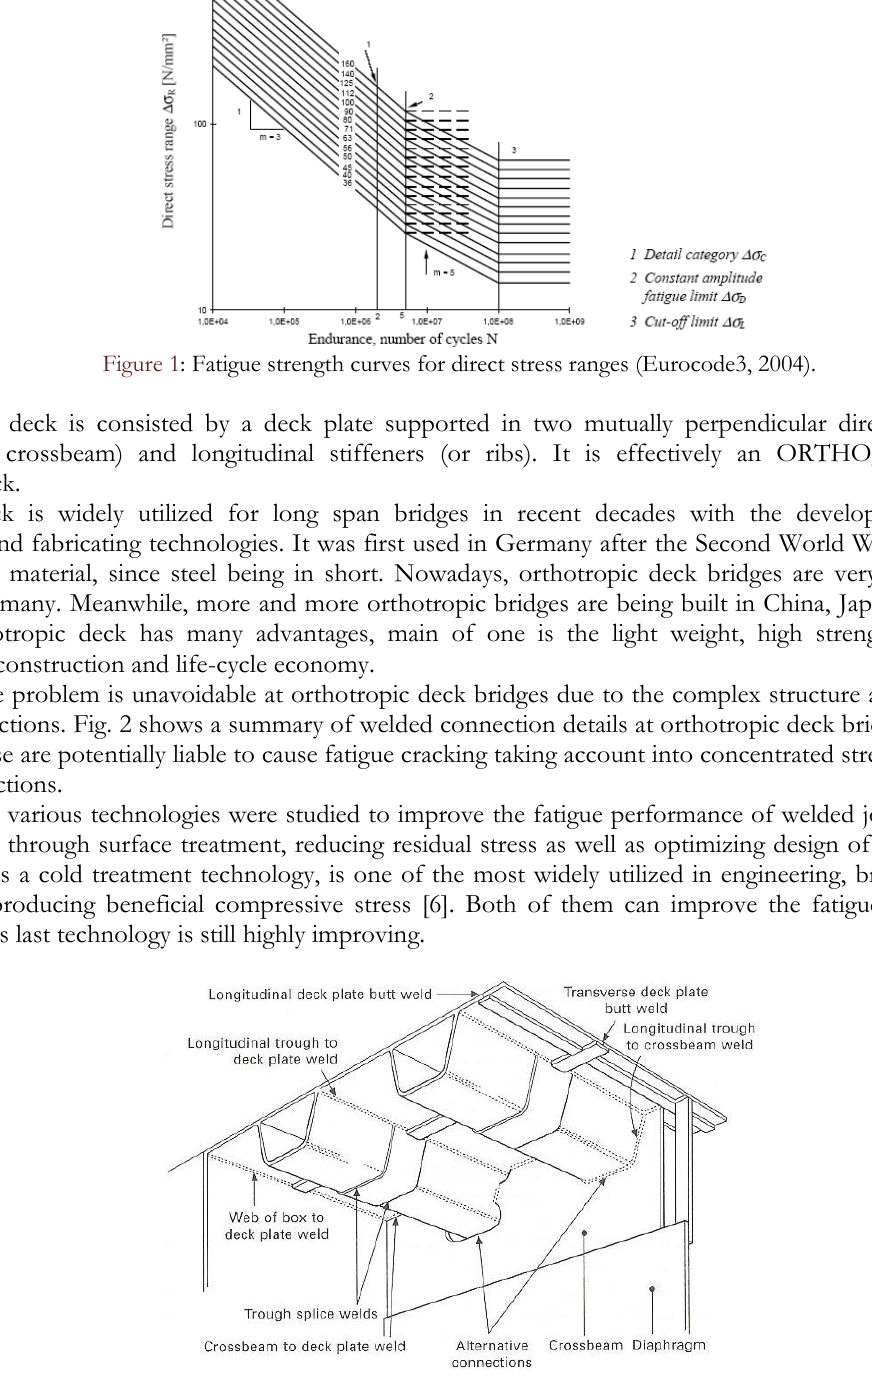
Figure 2: Main welded connections in a typical orthotropic bridge deck (Gurney,